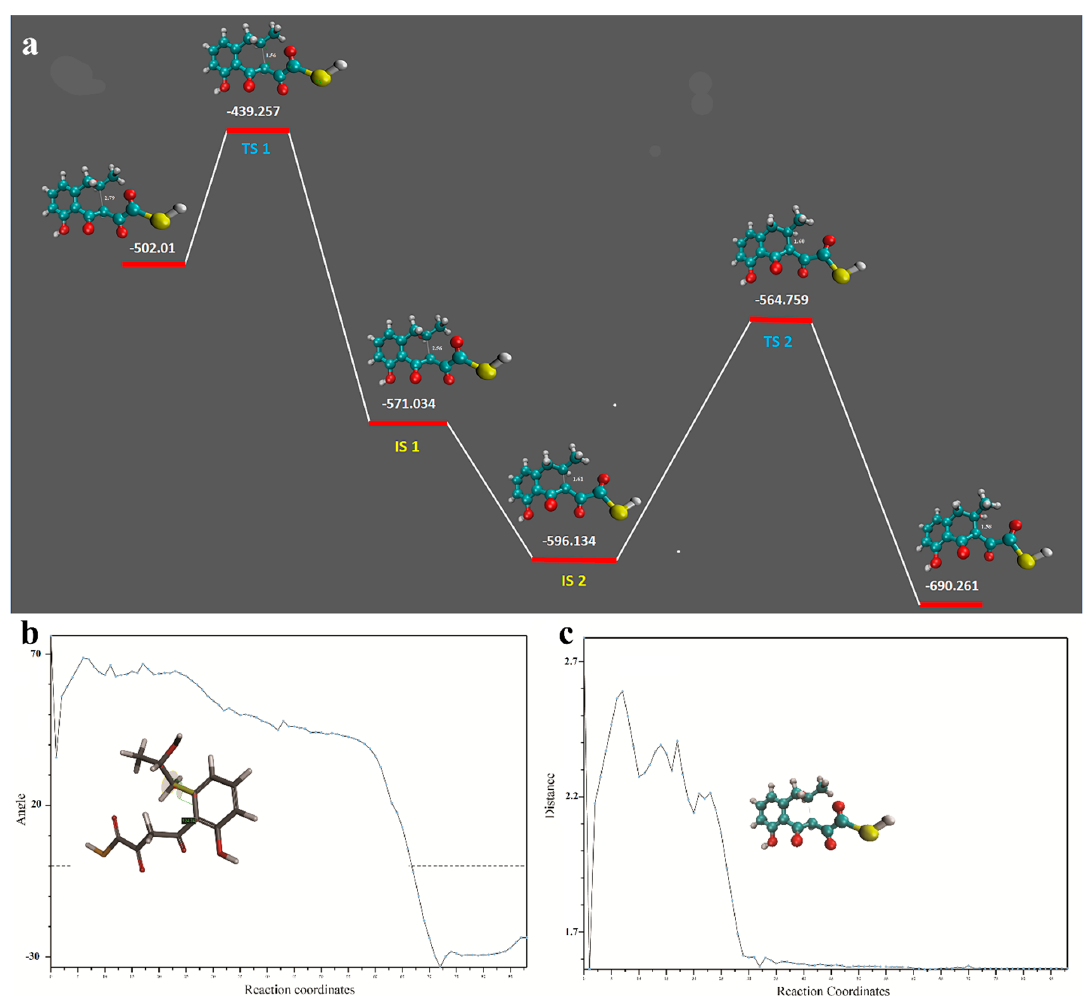
Figure 3. Quantum mechanics studies of OMB conversion. ( a ) The transition and intermediate states of the OMB to naphthalene intermediate. Dotted lines represent distance between the reactive atoms.